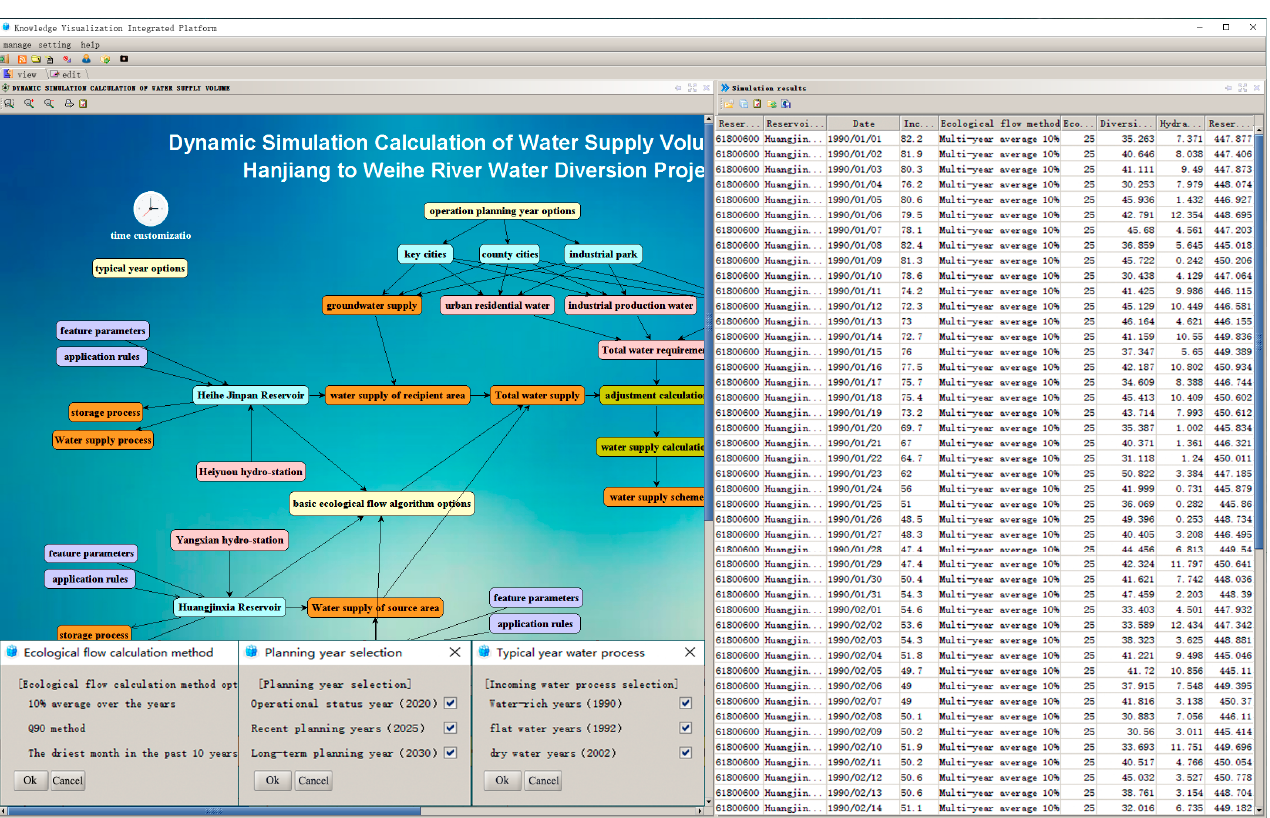
Figure 4. Computational components net of dynamic simulation system.